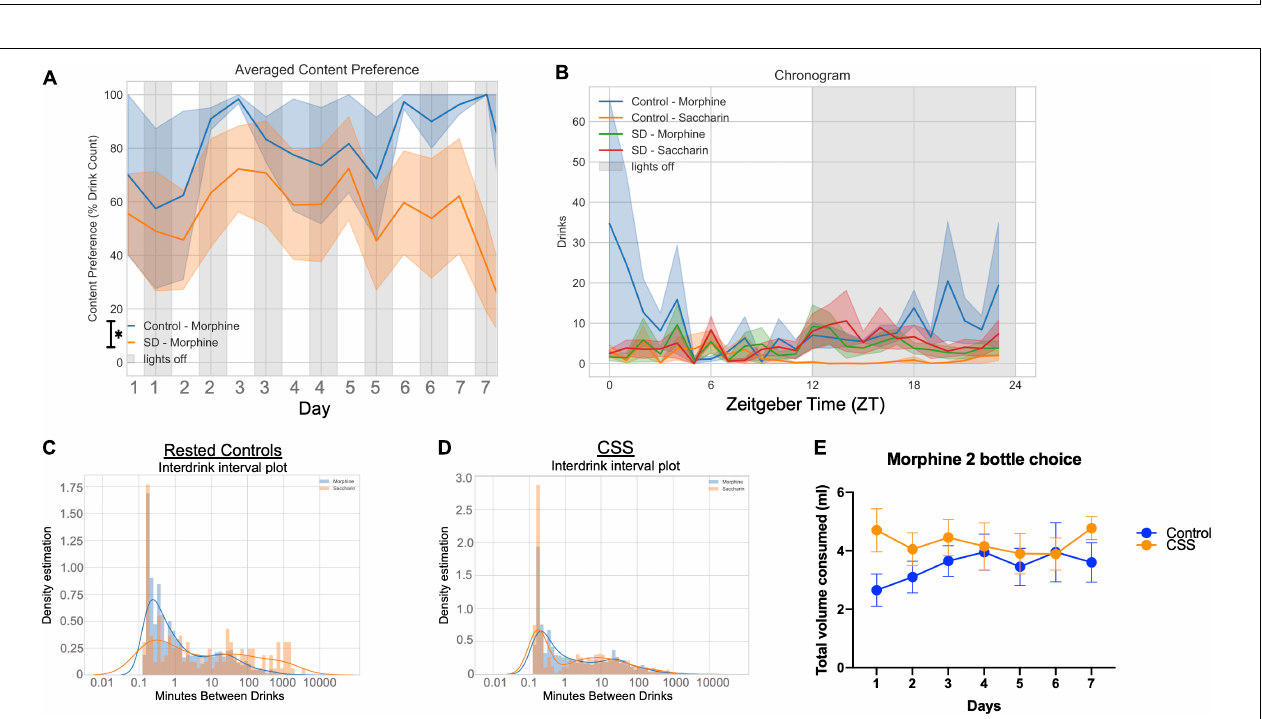
FIGURE 3 | (A) Average content preference over 7 days between rested and chronic short sleep (CSS) groups, plotted in 12-h bins. (B) Averaged chronogram showing drinks per hour of circadian time for all 7 days. (C) Interdrink interval between morphine and saccharin for the rested control group. (D) Interdrink interval between morphine and saccharin for the chronic short sleep group. (E) Total volume consumed, measured manually, of both morphine and saccharin combined for both the rested and sleep deprived groups.